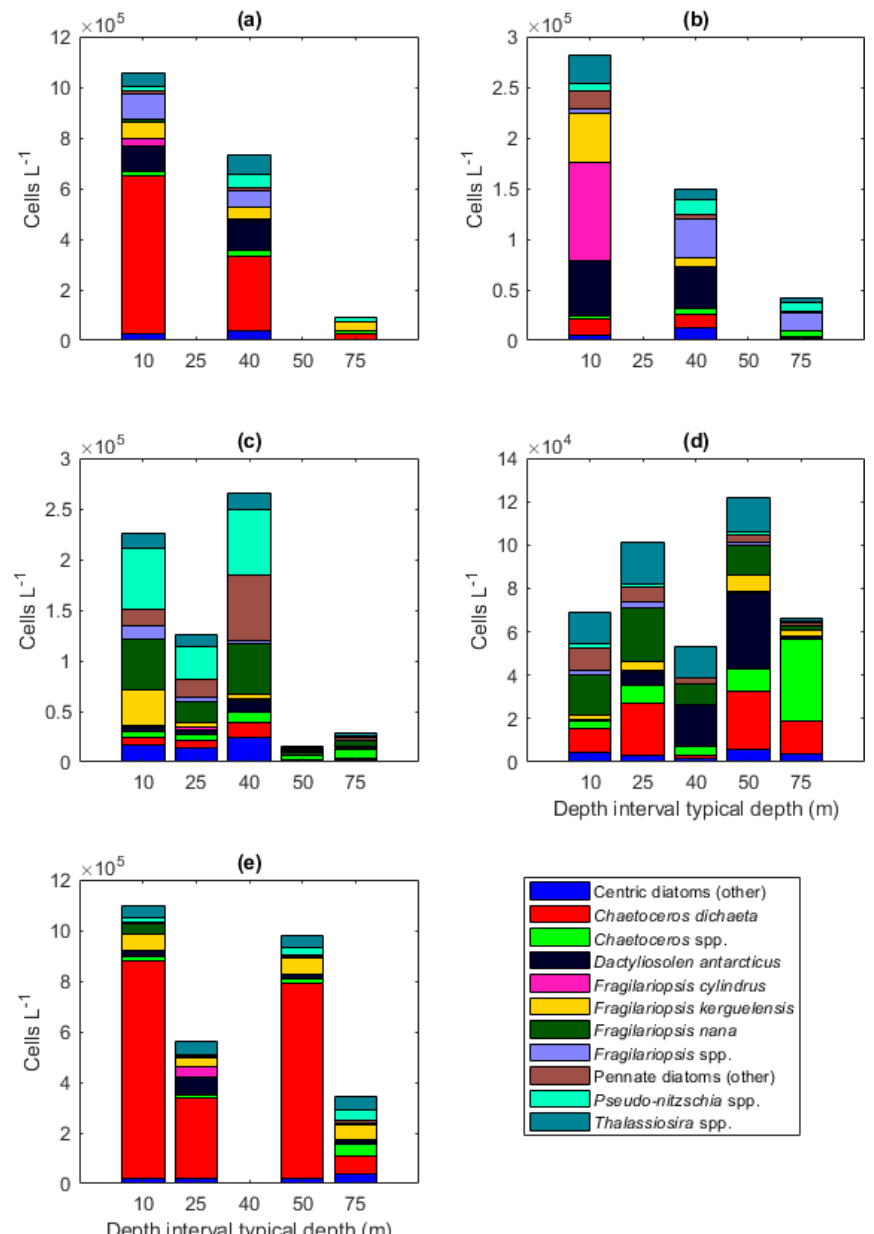
Figure A7. Diatom abundance in the different sampling areas averaged per depth interval for (a) station 53, (b) station 54, (c) Astrid Ridge, (d) the 6 ◦ E transect, and (e) Maud Rise. Depth intervals (with typical sampling depth in brackets): 5–10 (10), 25–35 (25), 35–45 (40), 50–60, and 65–85